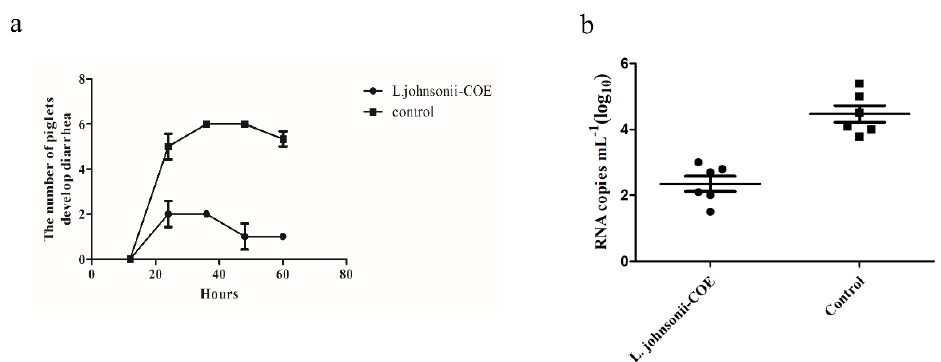
Figure 9. Detection of the levels of virus RNA in feces of the piglets and immune protective efficiency after challenging. ( a ) The quantity of piglets with diarrhea in the vaccinated L. johnsonii–COE group and normal breeding group after PEDV challenging. ( b ) RT–qPCR analyzed PEDV excretion in piglets.